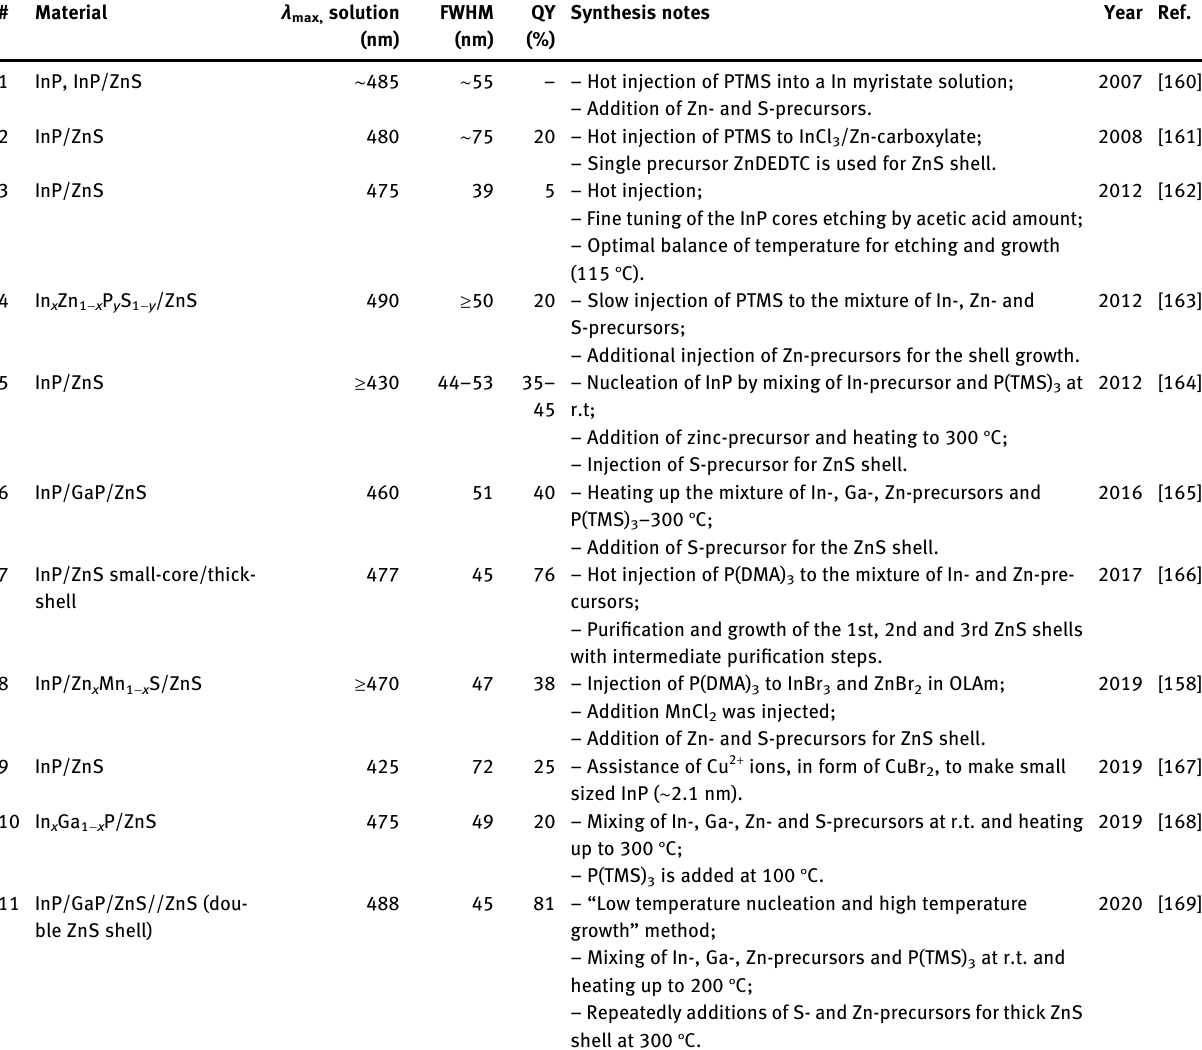
Table  : Blue-emitting InP-based nanoparticles, their PL performance and synthetic features.